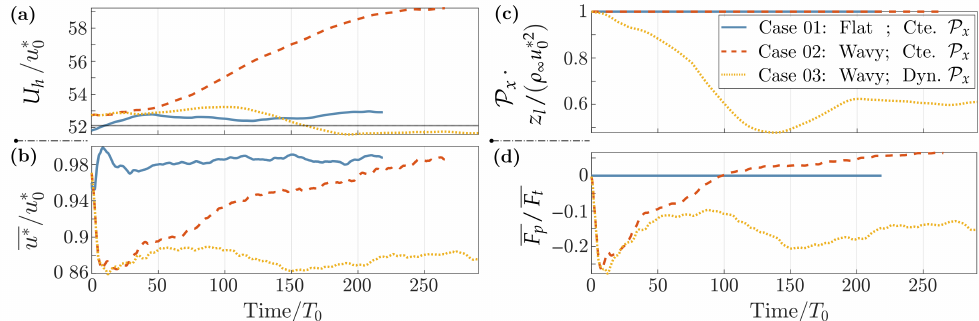
Figure 3. Time histories of non-dimensional: ( a ) wind speed at S z + ; ( b ) friction velocity; ( c ) large-scale pressure gradient; and ( d ) form drag. Averaged with t avg = 75 T 0 . Case 01: Flat bottom with constant P x , as the reference. Case 02: Wavy bottom with constant P x . Case 03: Wavy bottom with the dynamic P x